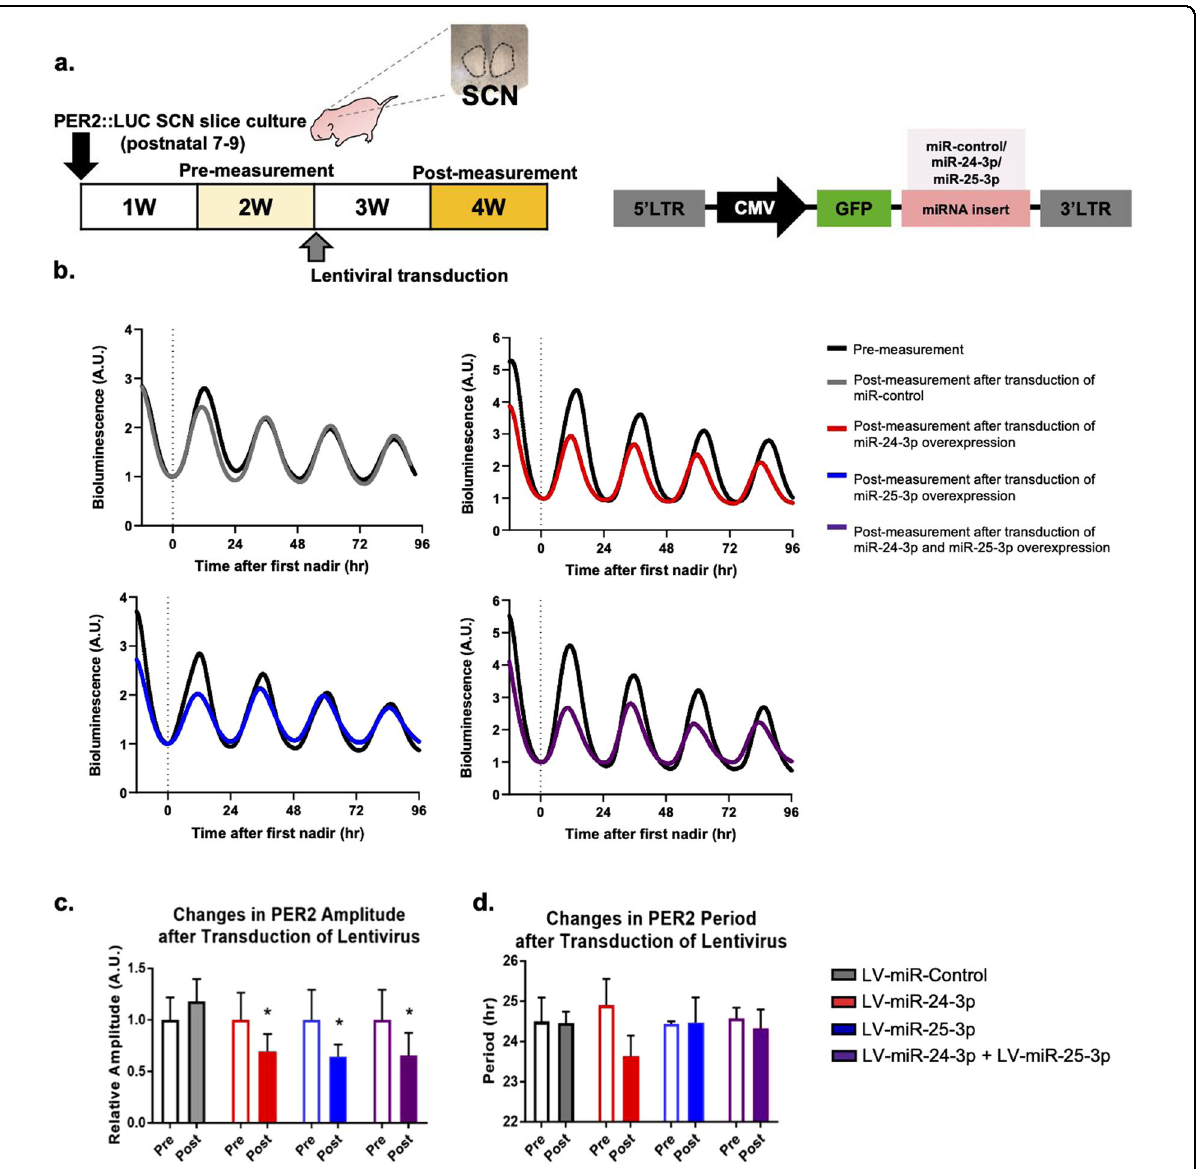
Fig. 5 Transduction of lentivirus overexpressing miR-24-3p and/or miR-25-3p dampens the PER2::LUC rhythm in the neonatal SCN slice cultures obtained from the PER2::LUC knock in transgenic mice. a Experimental design for transducing CMV-promoter driven lentivirus-miR- control/miR-24-3p/miR-25-3p-GFP in neonatal suprachiasmatic nucleus (SCN) slice cultures. b Representative results of PER2::LUC oscillation measured by a real-time bioluminescence recording device. The bioluminescence patterns were aligned to the fi rst nadir of data acquired to compare changes in the expression patterns of PER2::LUC in the pre- and postlentiviral transduced SCN slice cultures (experiments were performed three independent times, n = 3). c Changes in PER2 amplitudes and periods are presented as the means ± SE. Signi fi cance was assessed by Student ’ s t test, * p < 0.01 compared to the prelentiviral transduction